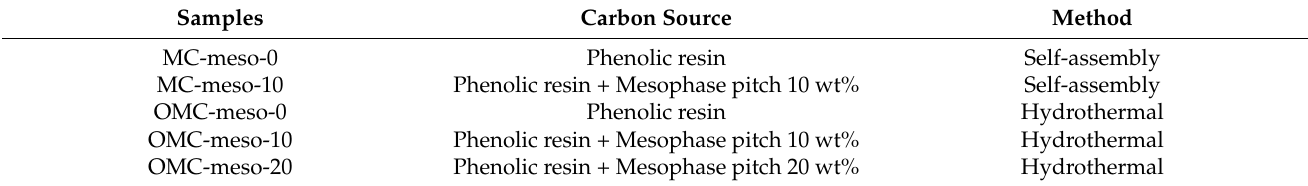
Table 2. Types of precursors and synthesis conditions of MCs and OMCs 1 .